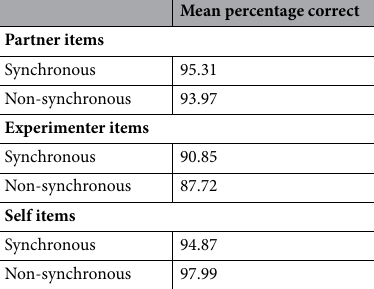
Table 7. Mean percentage correct scores for the preference overlap task.